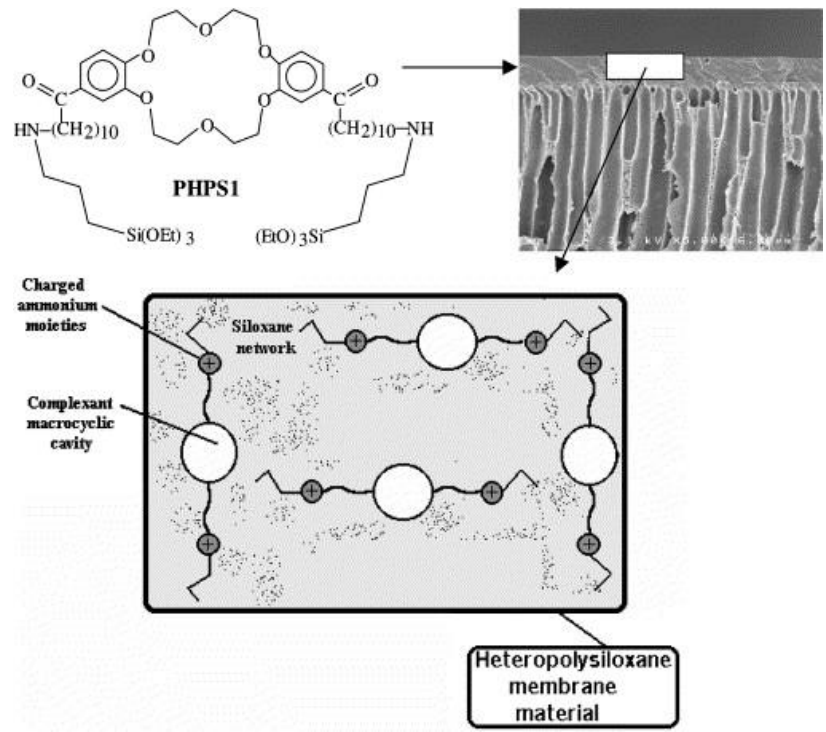
Figure 4. Scheme of fixed-site macrocyclic complexant membranes used in transport experiments. Reprinted from [30], © 2000 with permission from Elsevier.